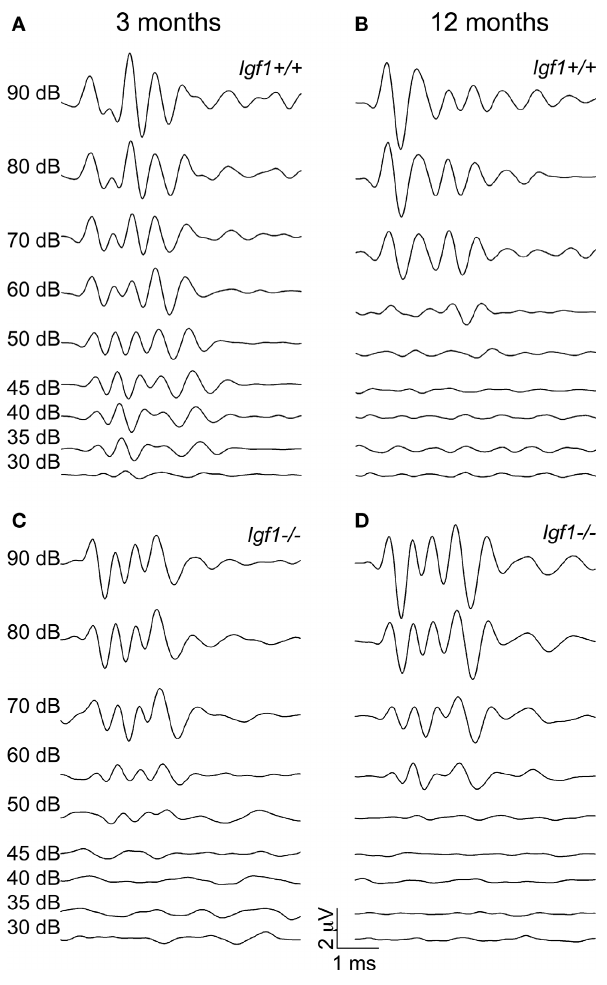
Figure 1 | ABr wave recordings from representative 3- and 12-month- old Igf1 + / + wild type and Igf1 − / − null mice. The waves represent the ABR in response to intensities of click stimuli decreasing from 90 dB SPL to 30 dB SPL of a representative mouse for each condition. (A,B) ABR waves from 3- (A) and 12- (B) month-old Igf1 + / + mice. (C,D) ABR waves from 3- (C) and 12- (D) month-old Igf1 − / − mice. In (A) and (C) the intensity of the stimulus for each response is indicated, and the range of intensities is the same in (B) and (D) .